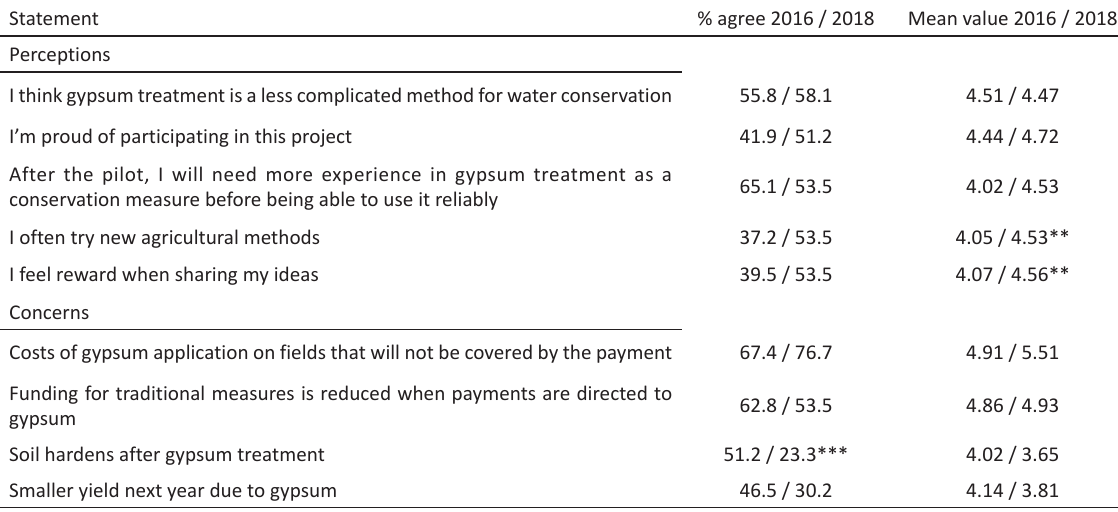
Table 3. Farmers’ perceptions and concerns on gypsum amendment; answers on 7-point Likert